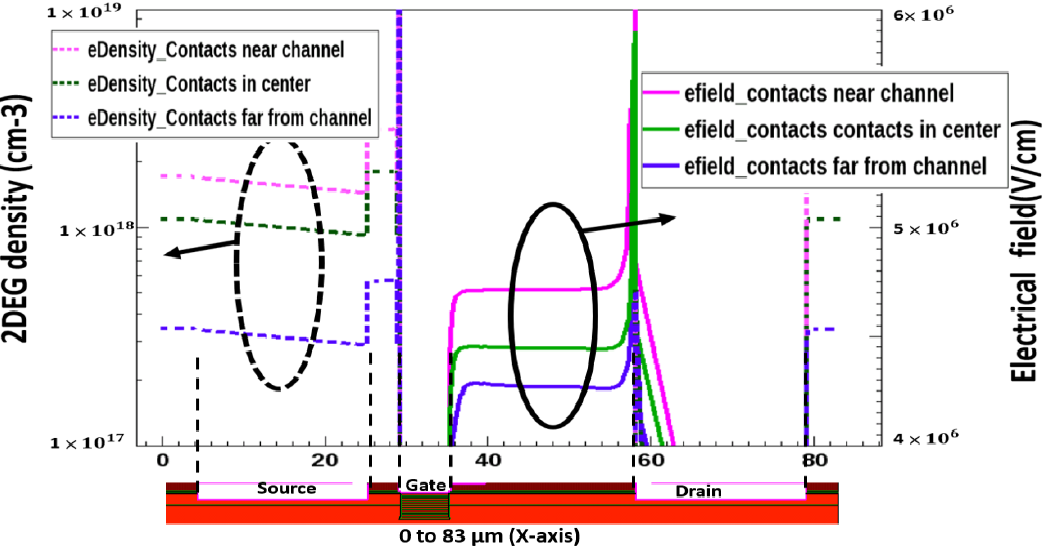
Figure 6. Simulation profile of 2DEG density and Electrical field distribution in AlGaN/GaN de- vice.